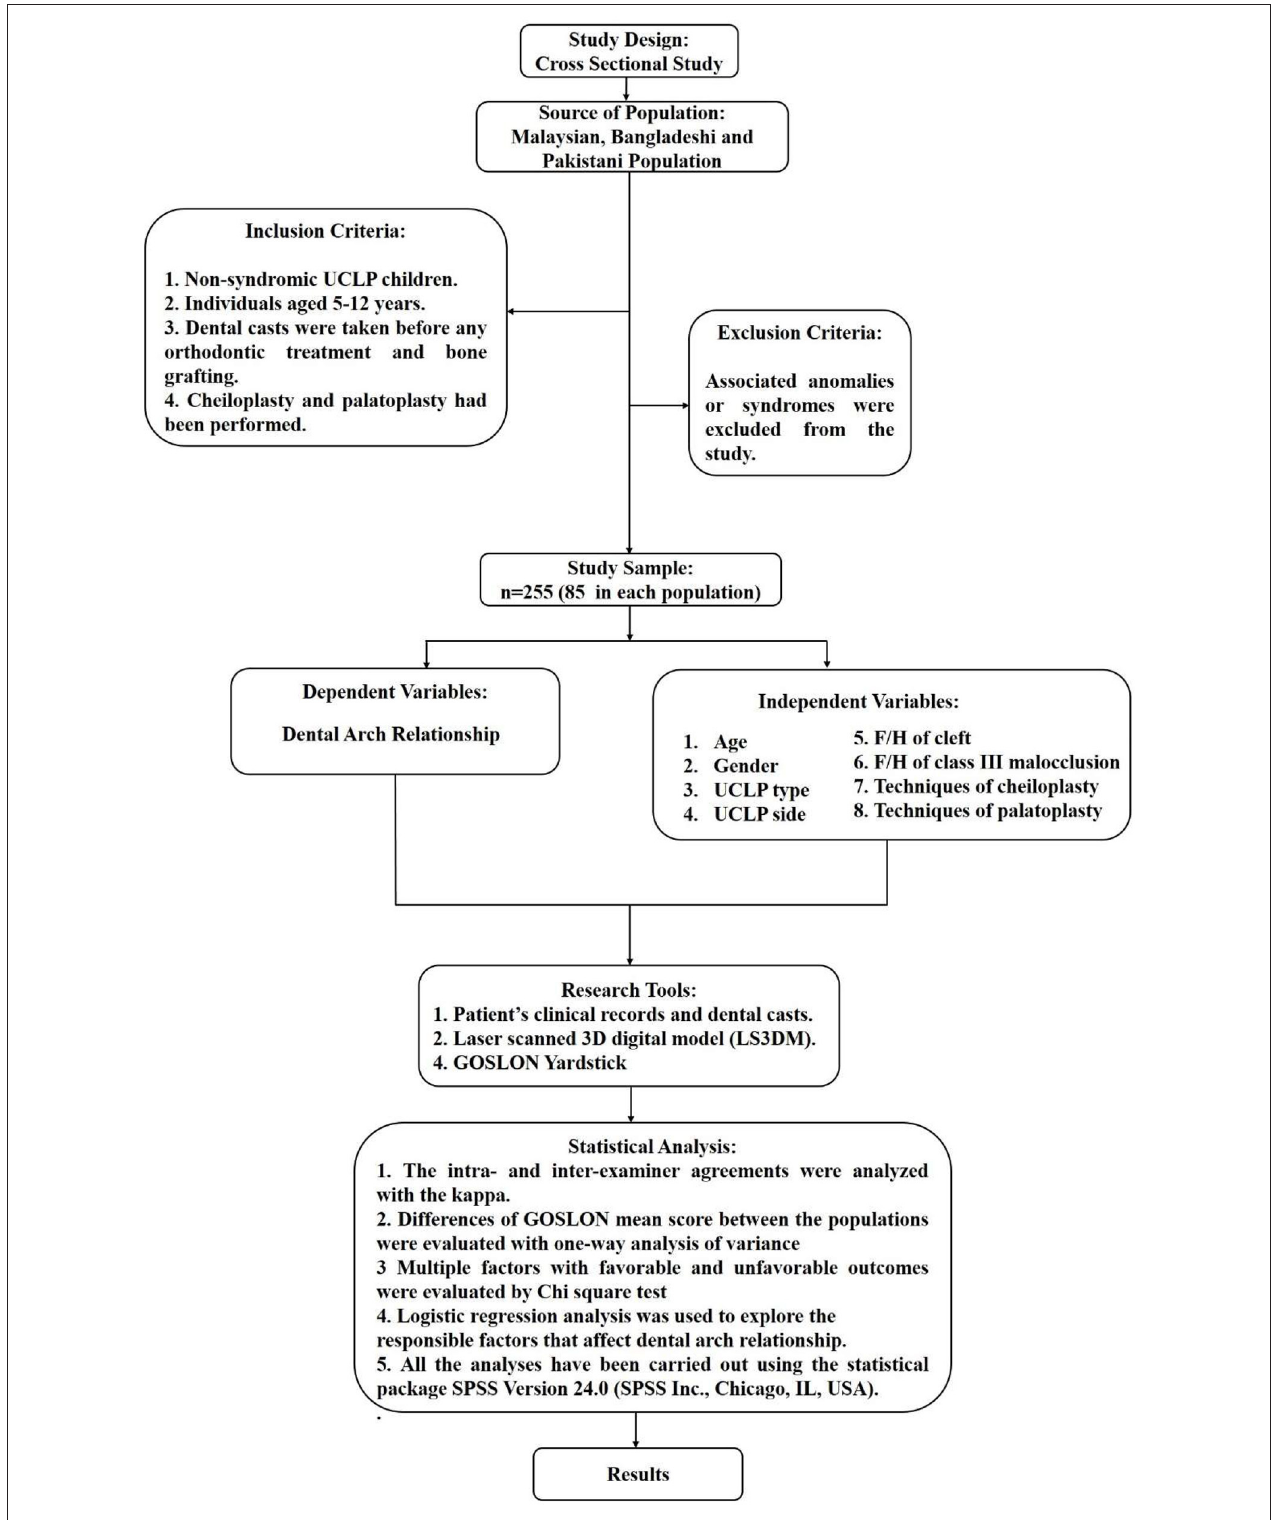
FIGURE 2 | The flow chart of the